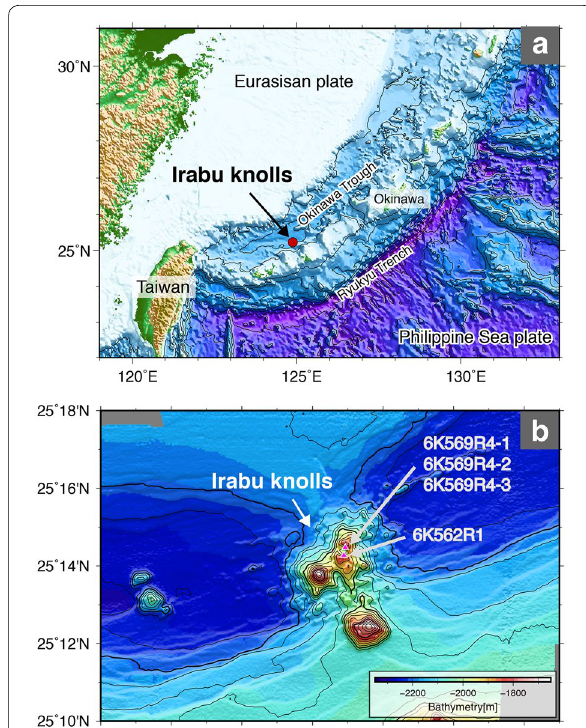
Fig. 1 Regional (top) and local (bottom) bathymetric map shown with locations of studied volcanic rocks collected in the Irabu knolls of the Okinawa Trough. Contour intervals of top and bottom maps are 1000 m and 40 m,